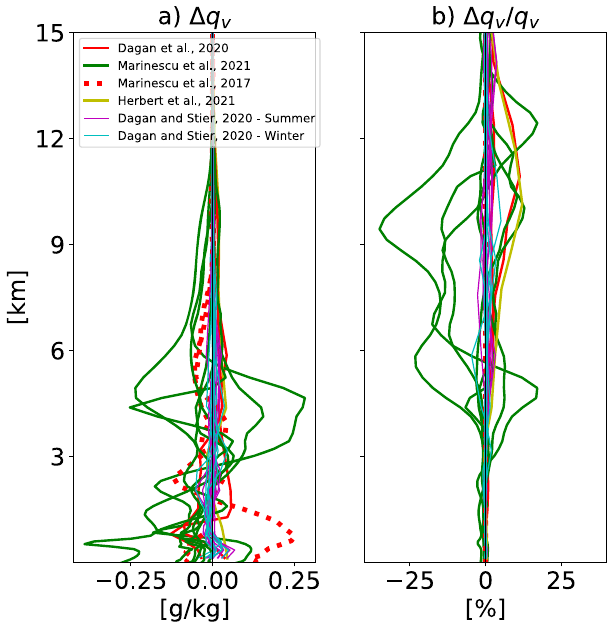
Fig. 2 Water vapor mixing ratio response to aerosol perturbation in realistic deep-convective clouds simulations. Vertical pro fi les of the domain and time mean a change in water vapor mixing ratio — q v , and b relative change in q v due to an aerosol perturbation (normalized to an order-of-magnitude increase in aerosol concentration). Same as Fig. 1 but focused only on the realistic simulations. The different green curves represent different models that participated in Marinescu et al. 11